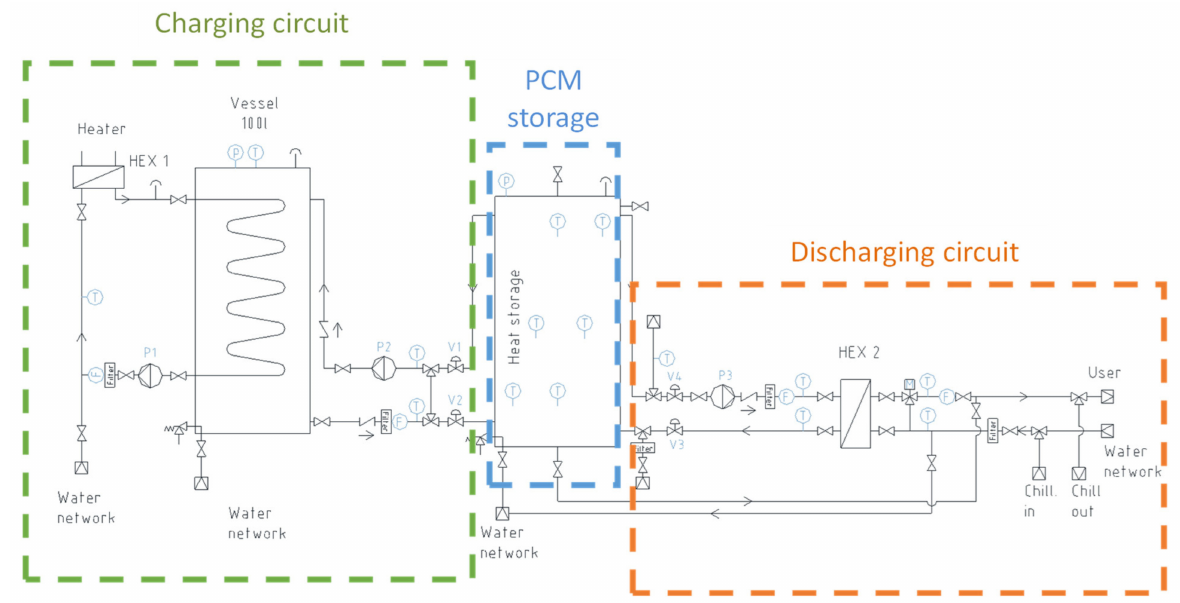
Figure 5. Schematic representation of the testing rig employed for the TES testing, highlighting the charging and discharging circuits.